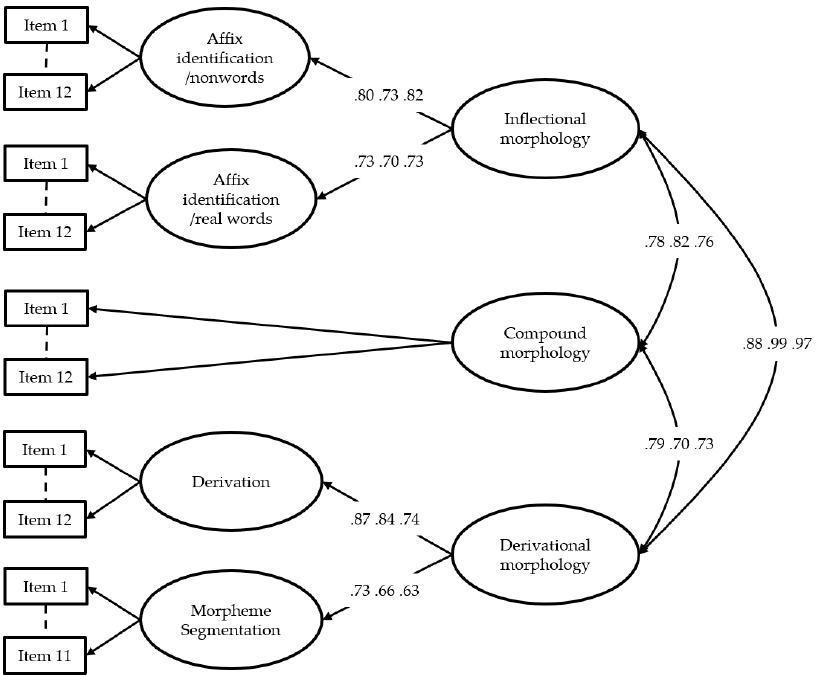
Figure 4. Results of the hierarchical model with factor loadings. The factor loadings are depicted in the order of the grades, respectively (grades 2, 3, and 4).